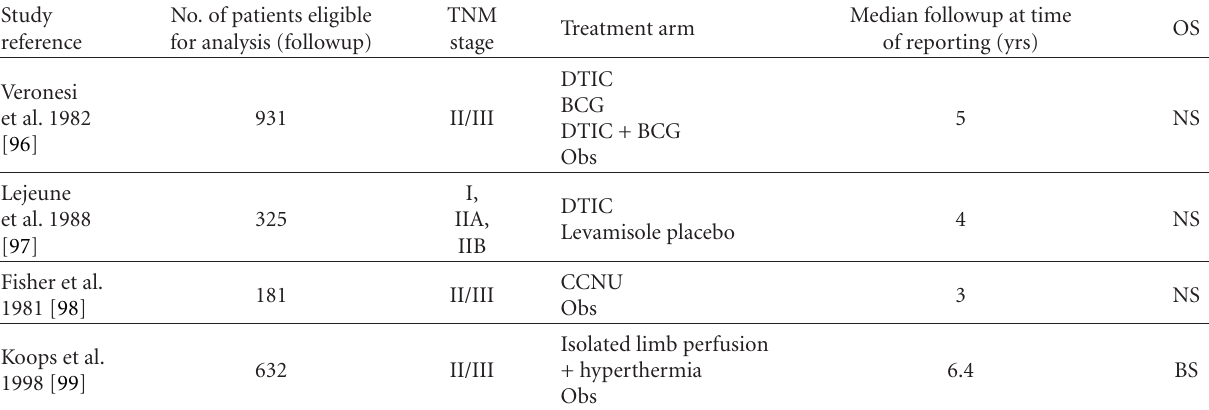
Table 3: Phase II/III studies of chemotherapeutic agents in